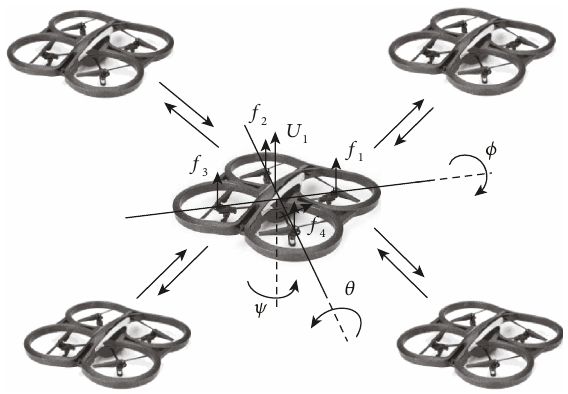
Figure 2: Multiquadrotor